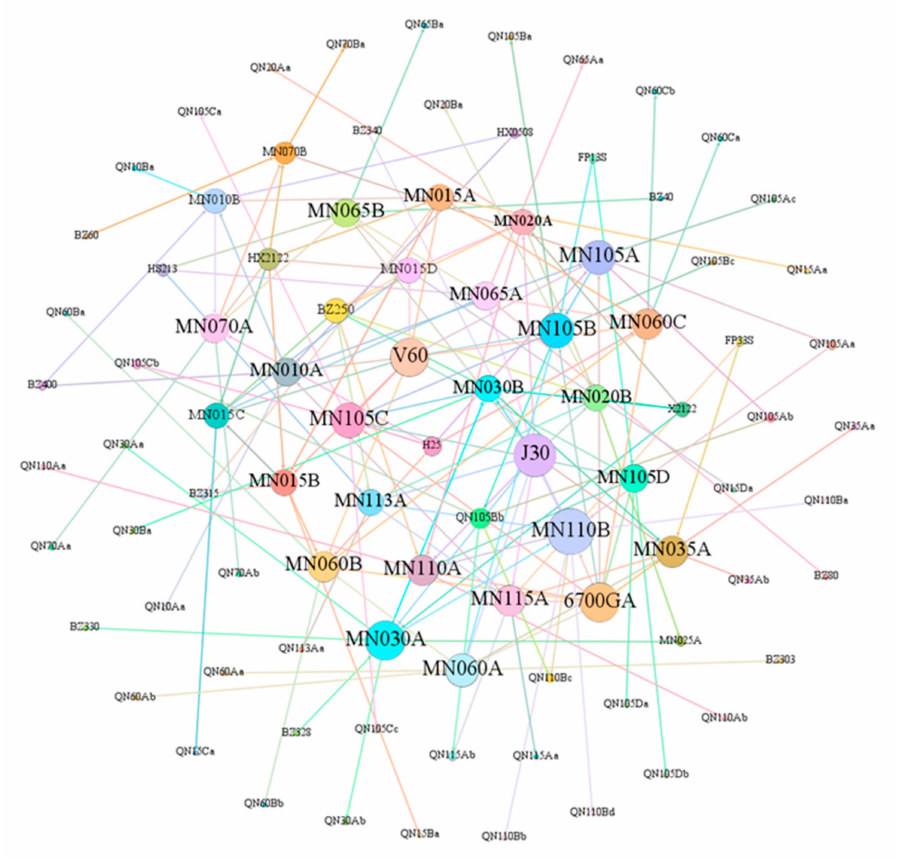
Figure 5. Diesel engine body machining error transfer